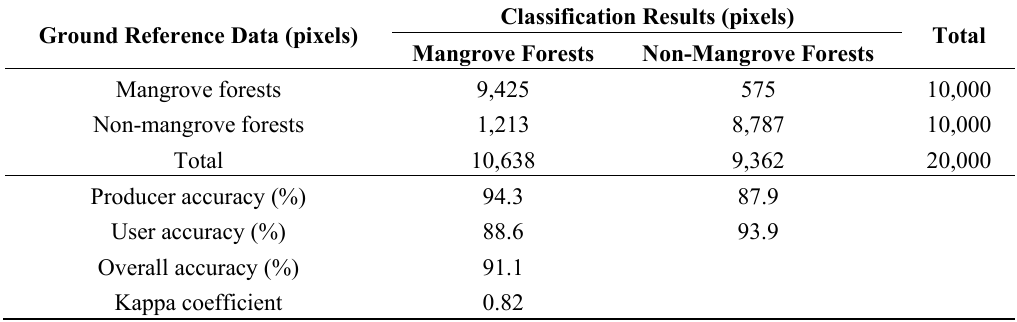
Table 2. Results of accuracy assessment from the classification of the 2002 Landsat ETM+